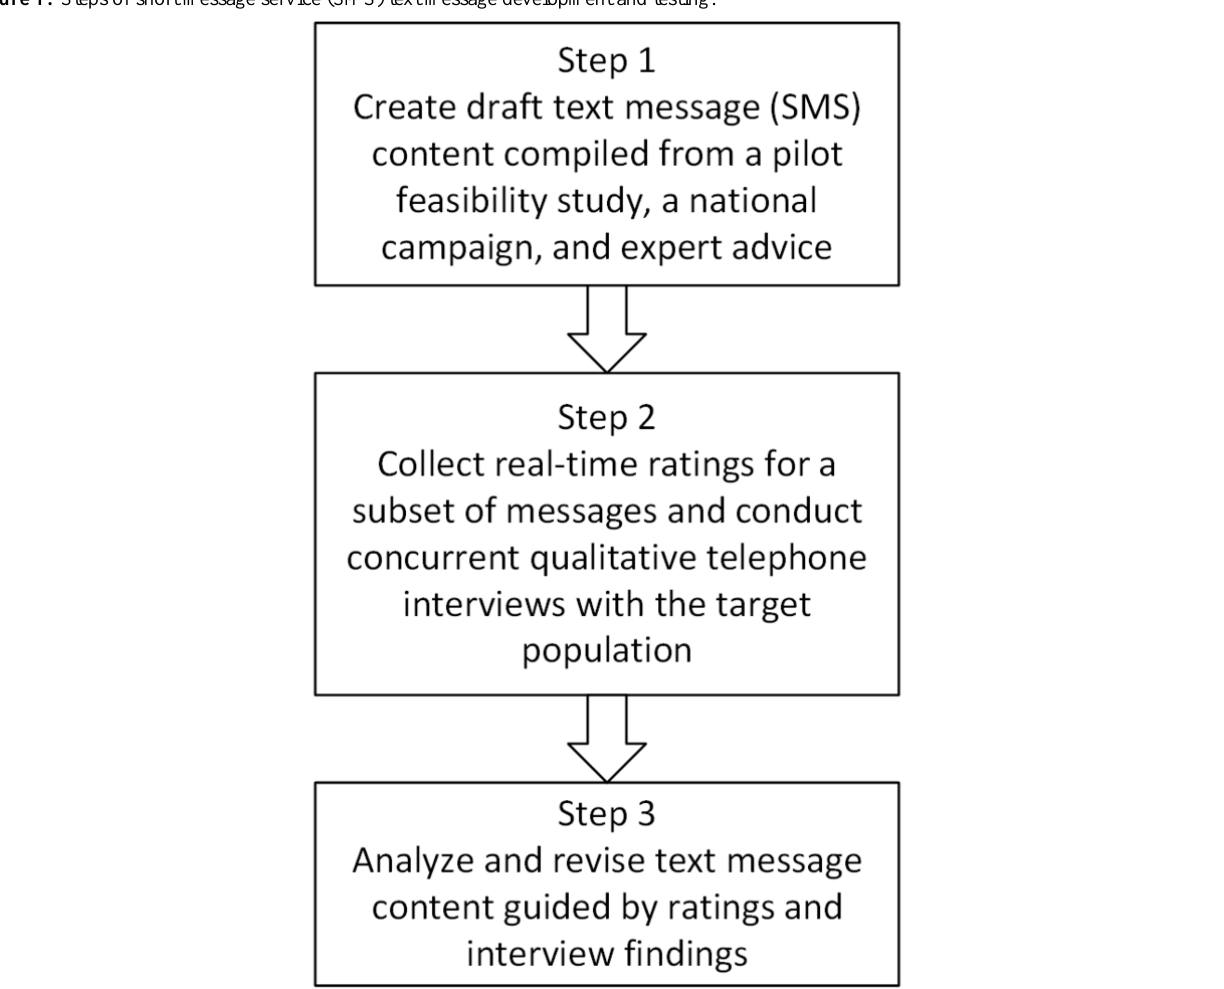
Figure 1. Steps of short message service (SMS) text message development and